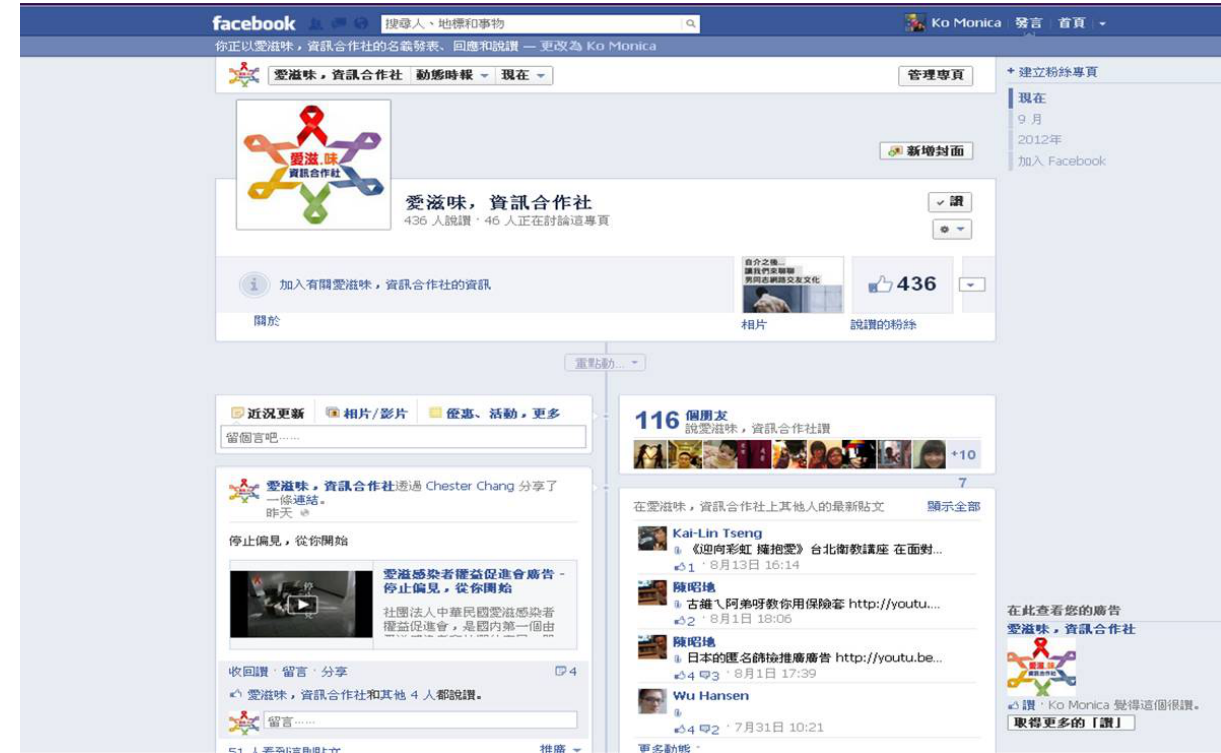
Figure 1. Sample iPOL platform on Facebook in